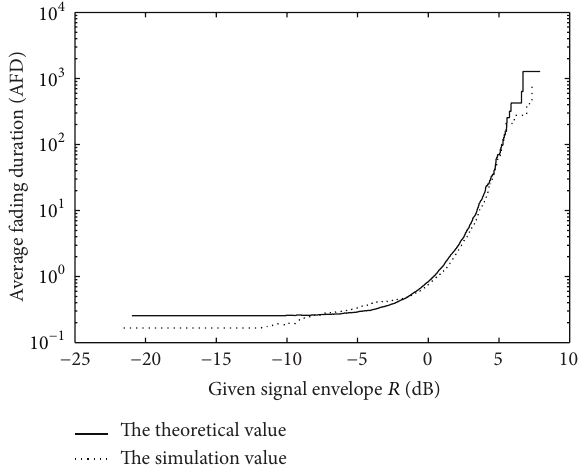
Figure 3: The cumulative probability curve of Corazza model.